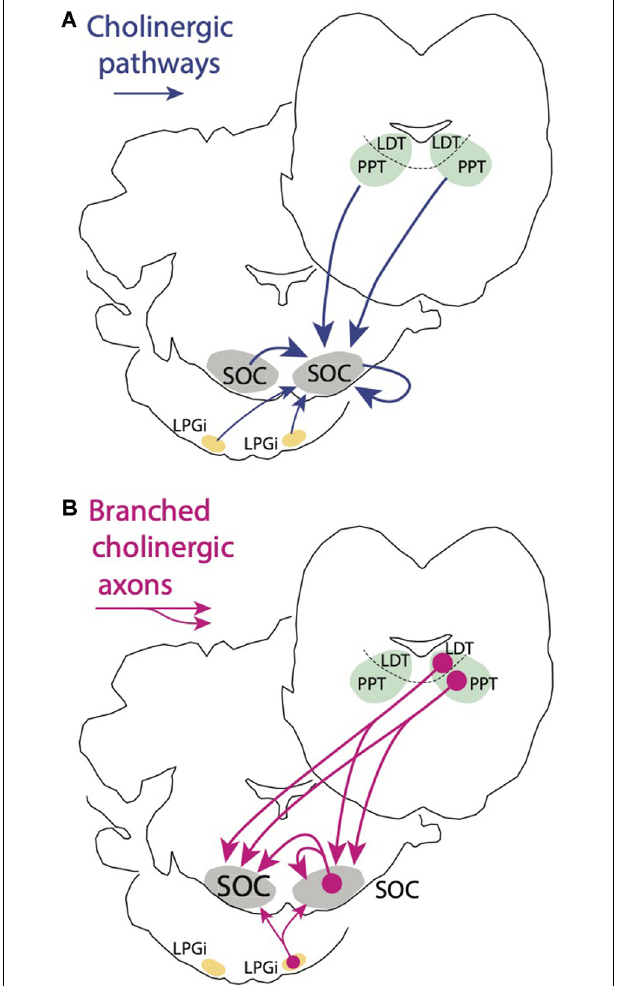
FIGURE 9 | Schematic summarizing major findings from the present study. (A) Cholinergic inputs to each SOC originate from three areas. One area is the pontomesencephalic tegmentum (PMT), comprising the pedunculopontine tegmental nucleus (PPT) and the laterodorsal tegmental nucleus (LDT). Each SOC receives cholinergic input from both ipsilateral and contralateral PPT and LDT. The second source of cholinergic input to the SOC is from SOC cells themselves. Each SOC receives cholinergic input from neurons within the same SOC as well as from neurons in the contralateral SOC. A third, smaller source is the lateral paragigantocellular nucleus (LPGi). Both ipsilateral and contralateral LPGi project to the SOC. (B) A second finding is that individual cholinergic neurons can send branching axons to innervate the SOC bilaterally. Such collateral projections can arise from cholinergic cells in each of the regions that supply cholinergic innervation to the SOC (for simplicity, projections are shown only from one